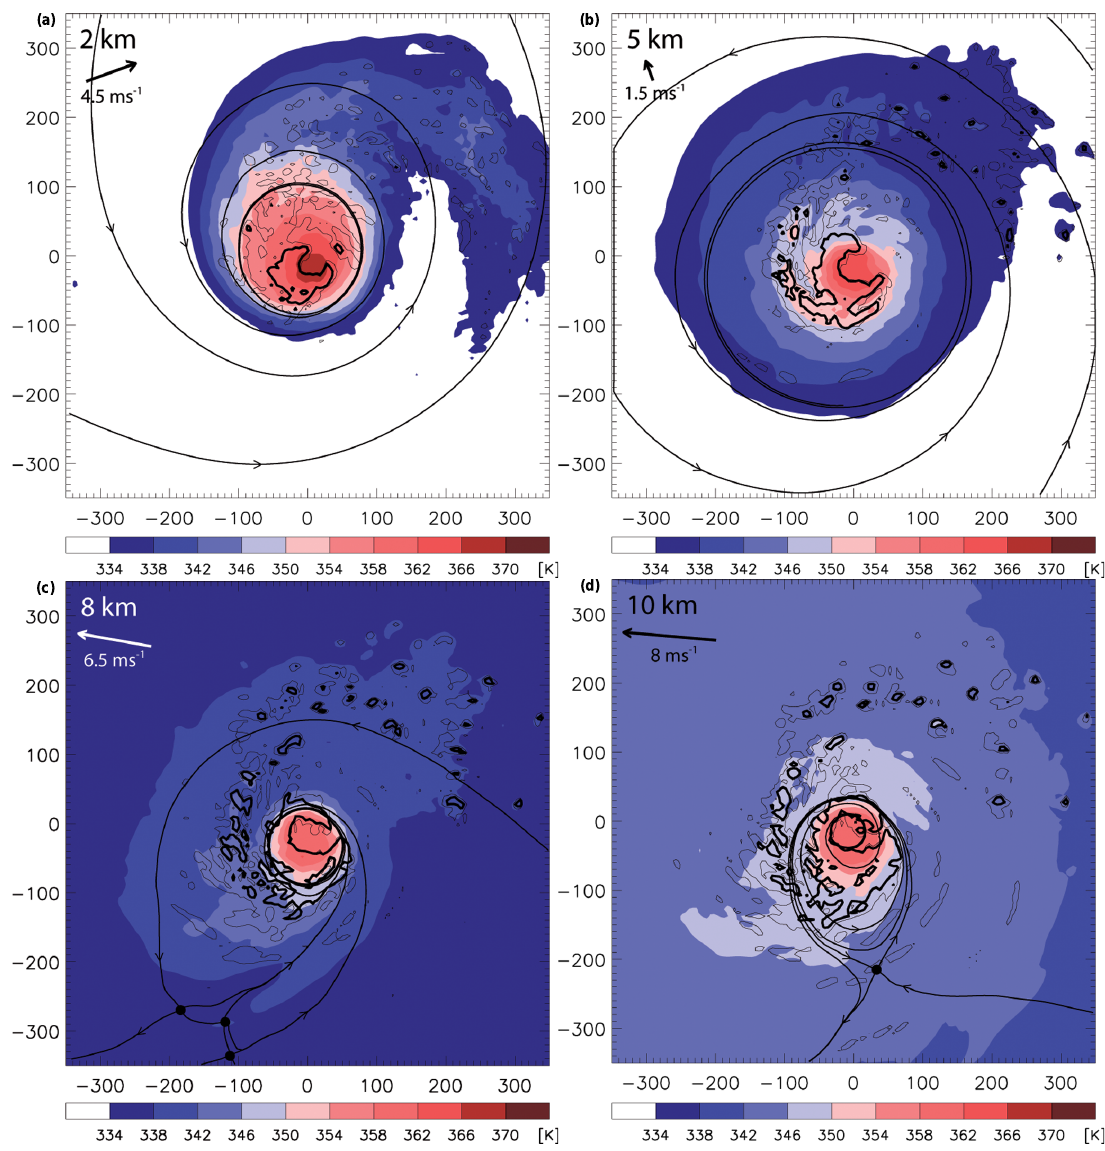
Fig. 4. Zoomed-in version of Fig. 3, including θ e (color shaded) and vertical motion (thin contour=0.25ms − 1 , thick contour=1ms − 1